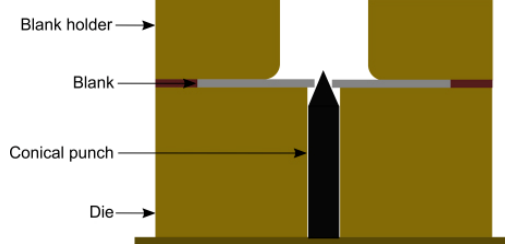
Fig. 1 Schematic representation of HET.